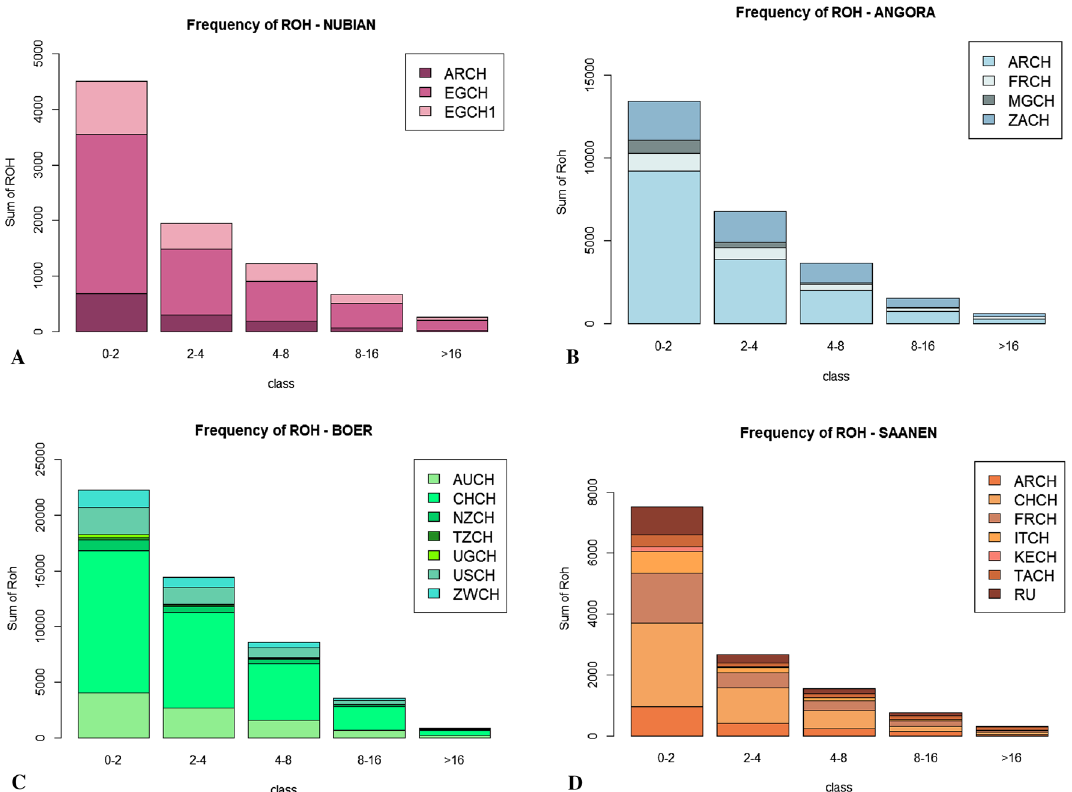
Figure 3. Frequency of Runs of Homozygosity for each class of length. Histograms are built with different colours for each breed (A = Nubian, B = Angora, C = Boer and D = Saanen) and every population is indicated with a different shade of the same colour.